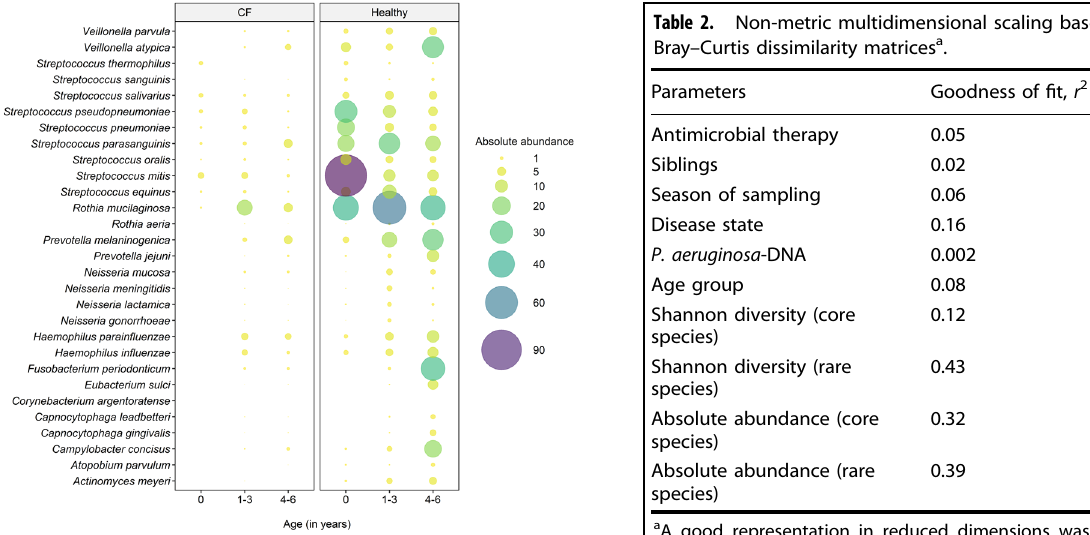
Fig. 2 Bubble plot of the median absolute abundance of core species in the respiratory tract of CF children (left) and healthy children (right) across age groups. CF children display lower absolute abundances of all core species in the respiratory tract compared to healthy controls across all age groups. The absolute abundance was calculated as described by Losada et al. 19 , where the length of the diploid human genome is divided by a million to account for the bacterial count scale. The quotient is multiplied by the normalised bacterial read count (normalised to a million reference base pairs) and the fi nal product is divided by the human read count. The statistically signi fi cant differences in absolute abundances are con fi rmed in Supplementary Fig. 2. In the CF